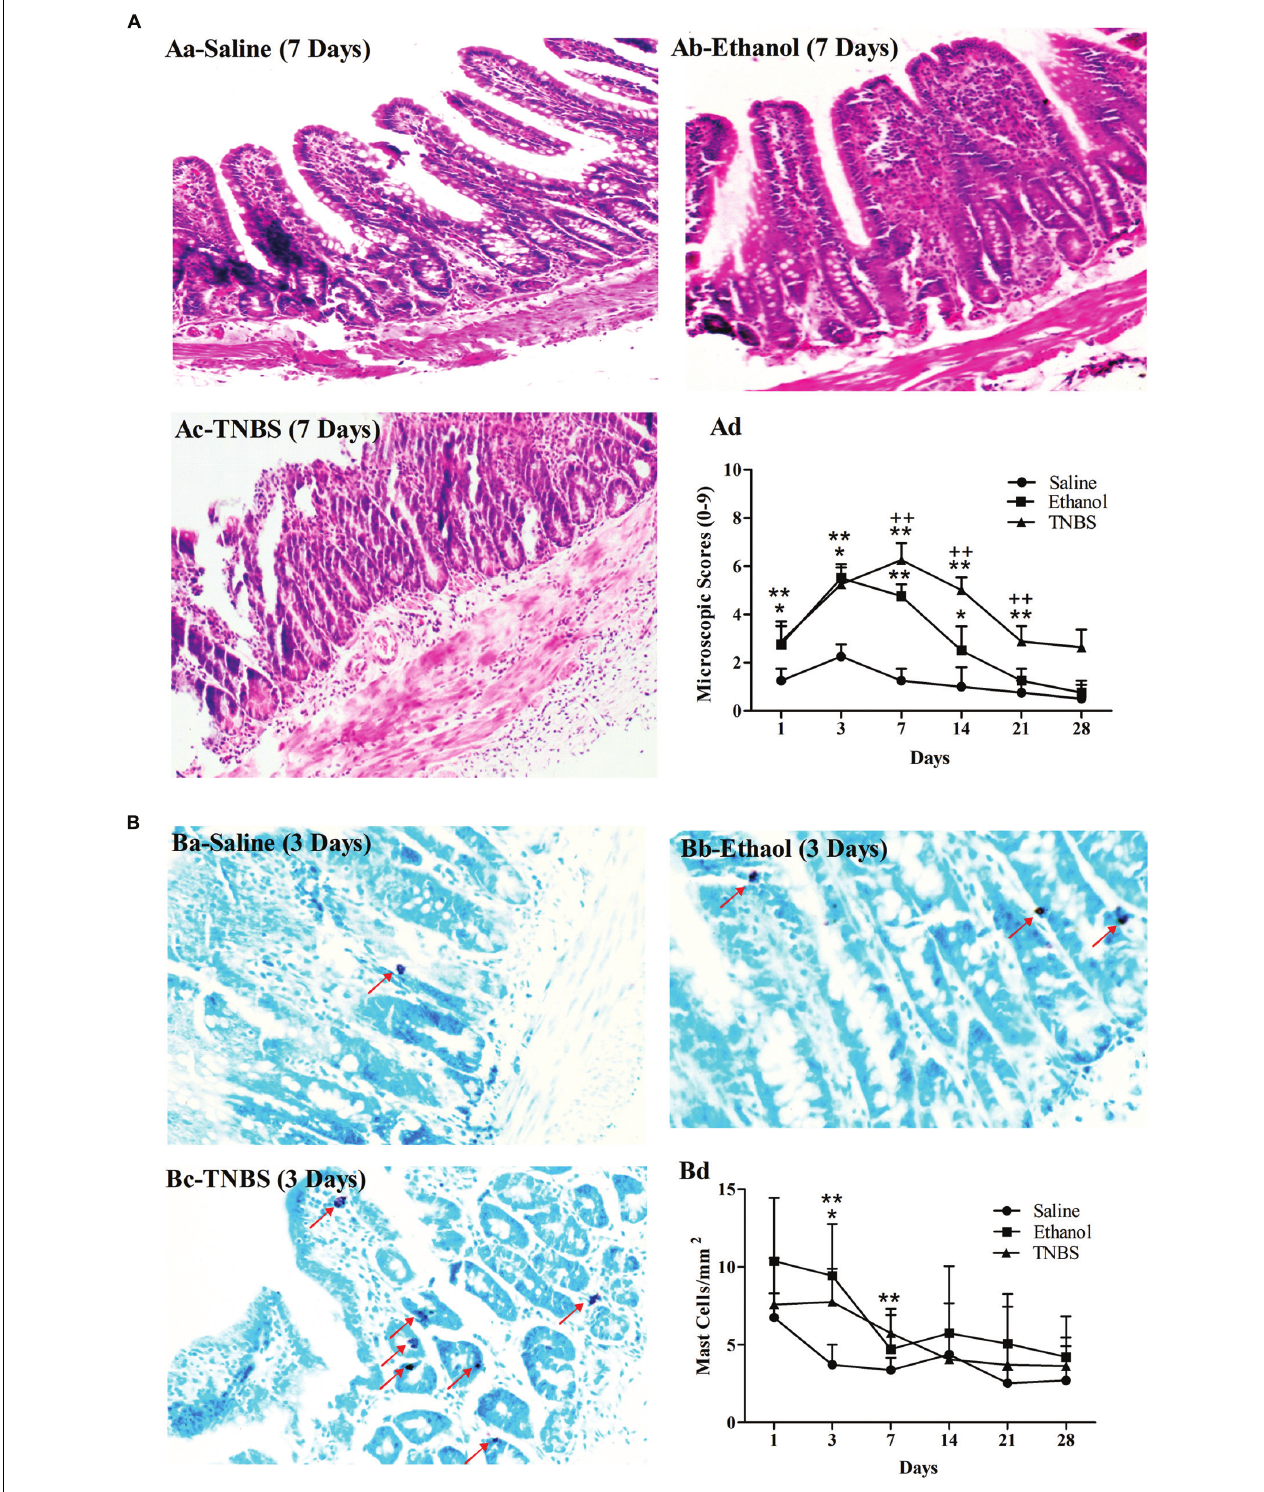
FIGURE 3 | Effects of TNBS administration on histopathology of the ileum in rats. Microscopic changes of the ileum stained with hematoxylin and eosin (H&E) (Aa–c) . The microscopic change scores on a 0–9 scale, crypt architecture (0–3), inflammatory cell infiltration (0–3), and ulceration (0–3) (Ad) . The morphological changes of the ileum stained with toluidine blue (Ba–c) . The number of the toluidine-blue-stained positive mucosal mast cells in the ileum (Bd) . ∗∗ P < 0.01, ∗ P < 0.05; TNBS group/Ethanol group vs. Saline group. ++ P < 0.01; TNBS group vs. Ethanol group. Kruskal–Wallis analysis followed by Mann–Whitney U -test.